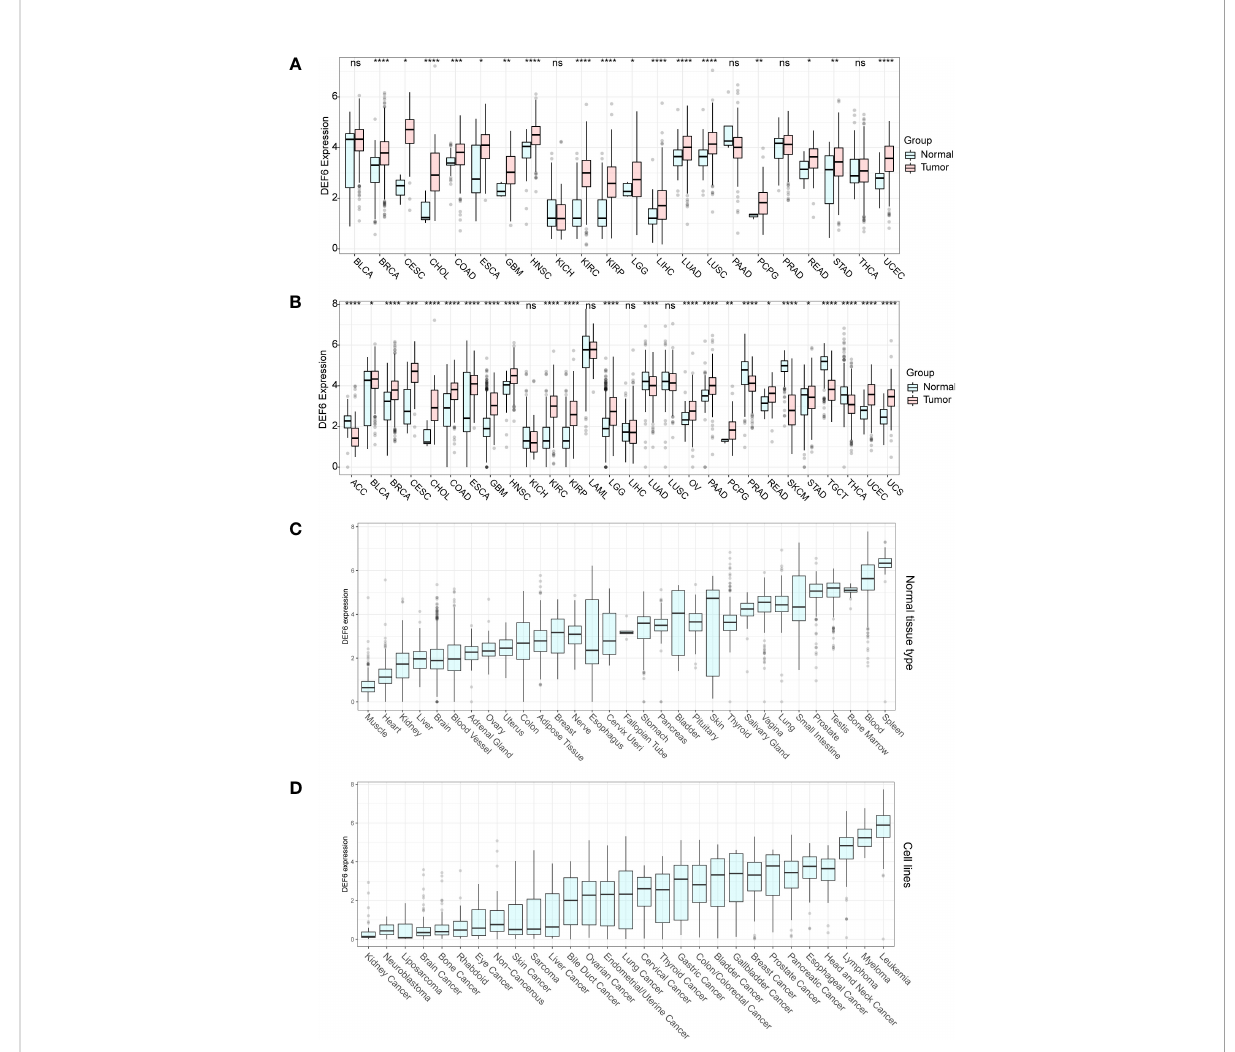
FIGURE 1 DEF6 expression pro fi le. (A) Differential expression of DEF6 in TCGA dataset. (B) Differential expression of DEF6 in TCGA dataset and the GTEx dataset. (C) Expression of DEF6 in normal tissues. (D) DEF6 expression at the cell line level. ns, not signi fi cant; * p < 0.05; ** p < 0.01; *** p < 0.001; **** p <